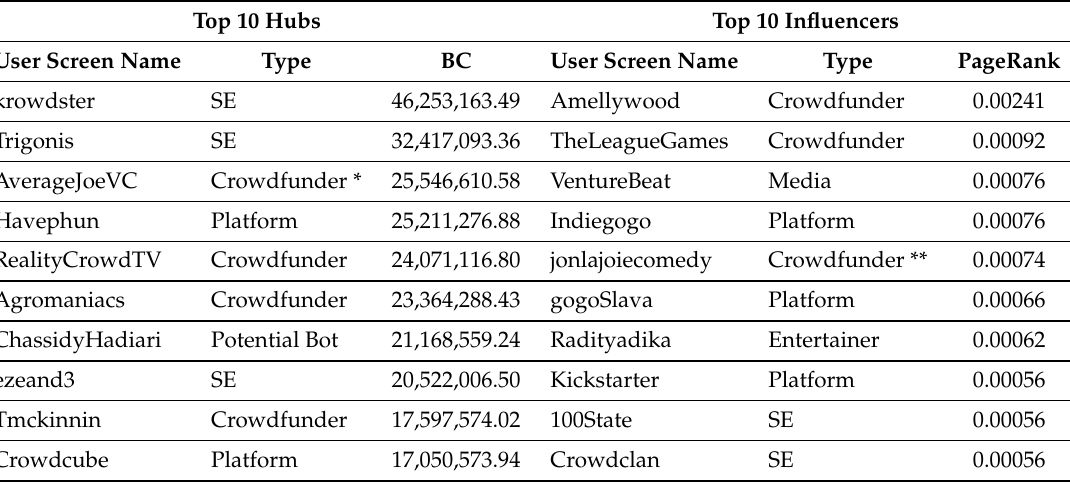
Table 1. Top 10 Hubs and